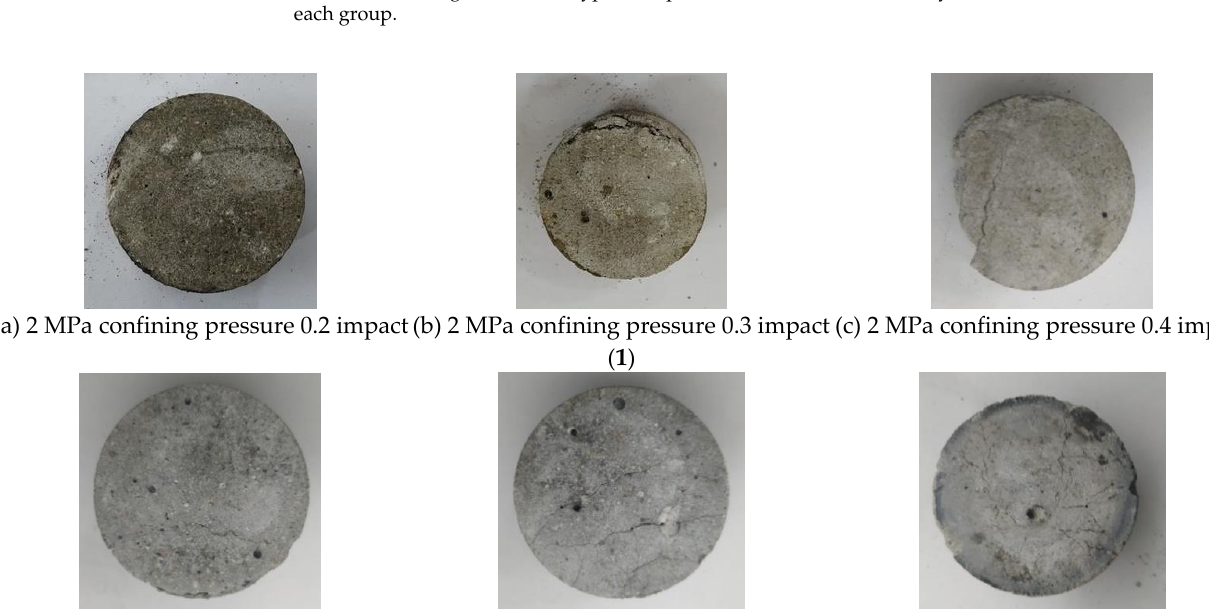
Figure 16. Failure modes of specimens under active confining pressure. ( 1 ) Similar material failure form of active confining mudstone, ( 2 ) similar material failure mode of active confining sandstone. Figure 16 shows that under the action of active confining pressure, the specimen is not apparently damaged when the active confining pressure of mudstone-like materials